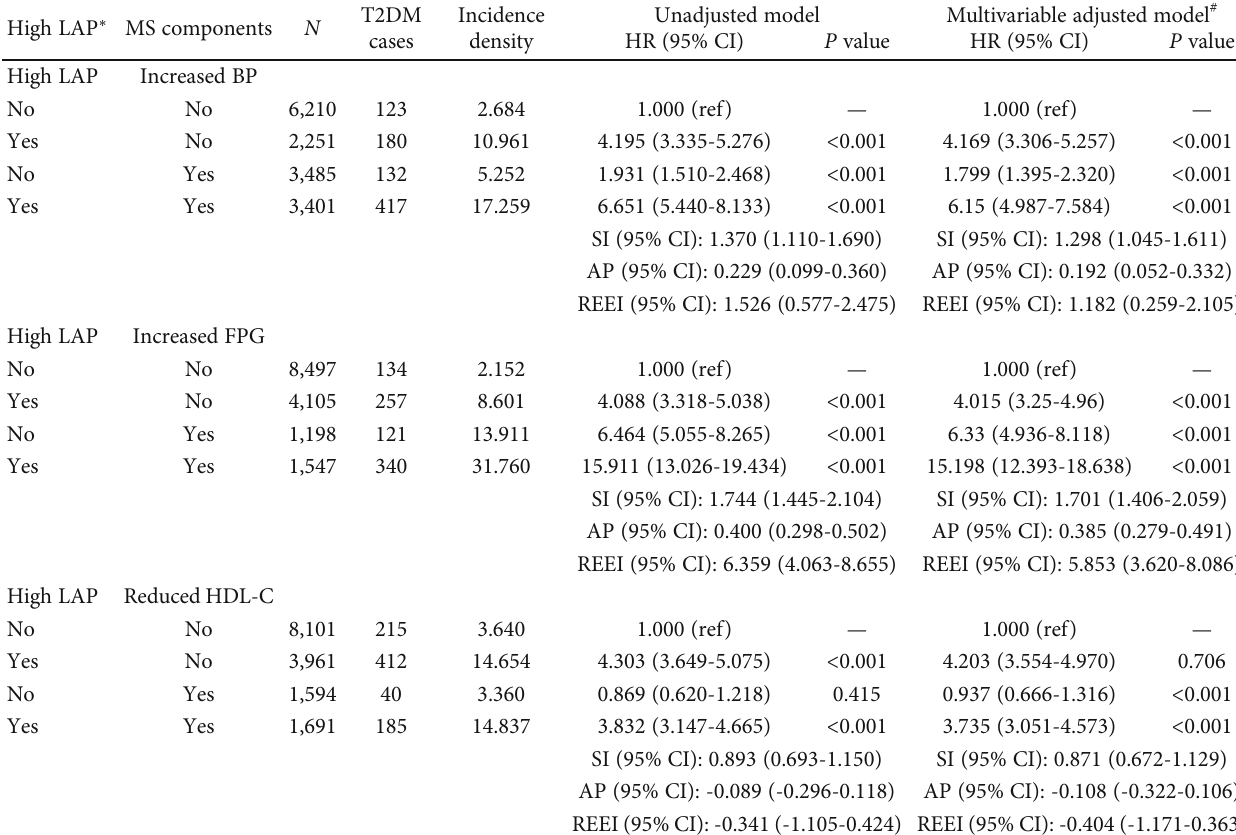
Table 5: Interactions between high LAP and other components of metabolic syndrome on the risk of